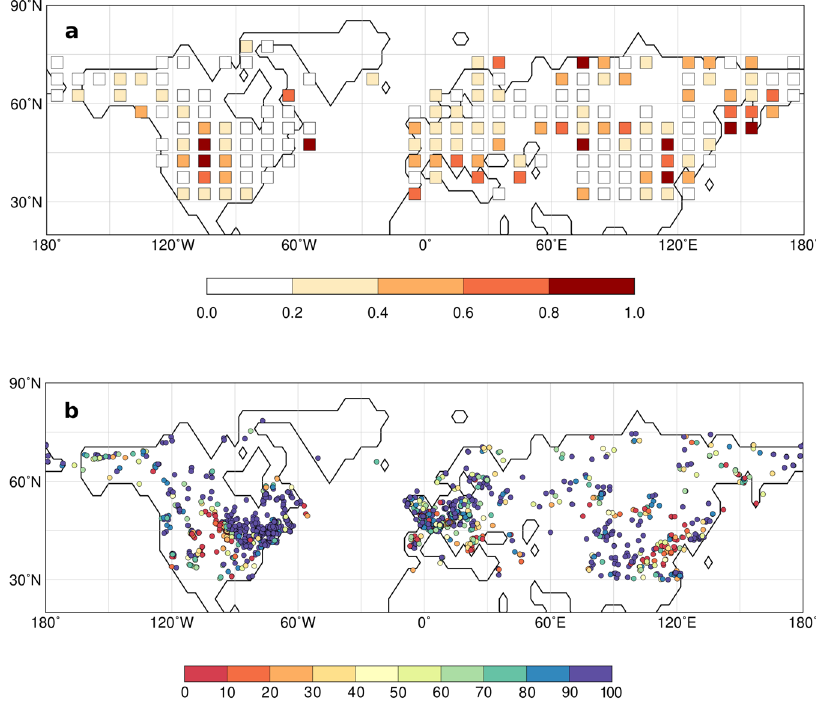
Fig. 4 | Agreement between the simulated and reconstructed forest distribu- tion. The simulated forest distribution at each time-step is compared to the reconstructed forest. a shows the mean difference in grid-cell forest cover for the entire period (22kyrs), i.e., the sum of differences in forest cover in each grid-cell